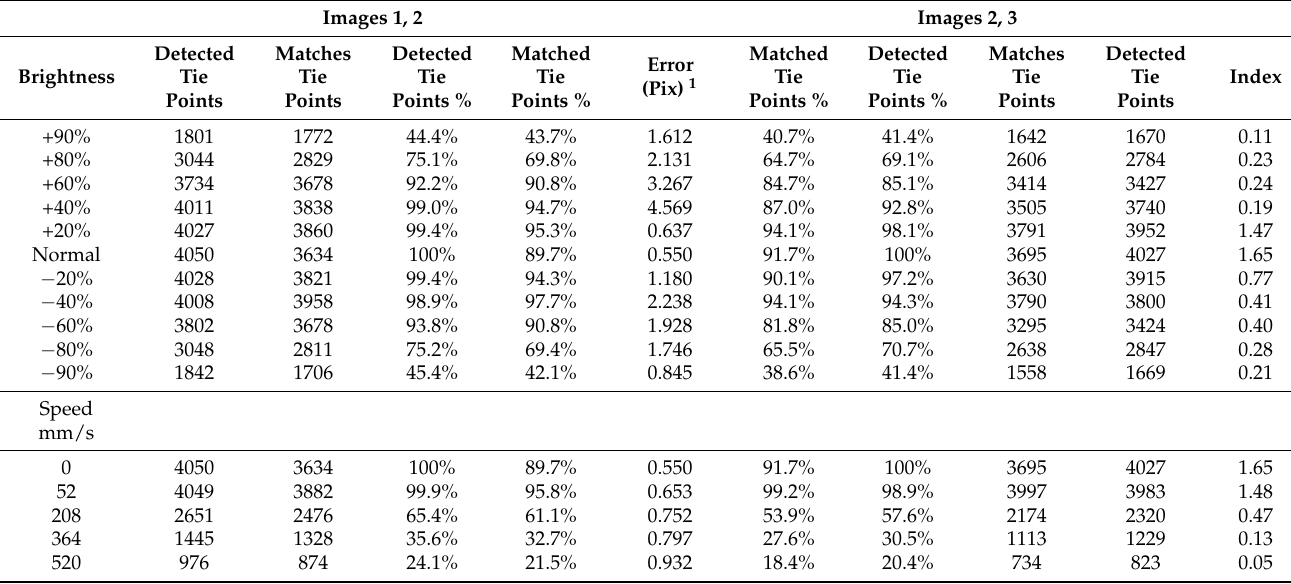
Figure 18. Matching the detected feature through structure from motion. Table 4. Effect of changing the brightness and the blurriness of the images on detected and matched features (tie points). Images 1,